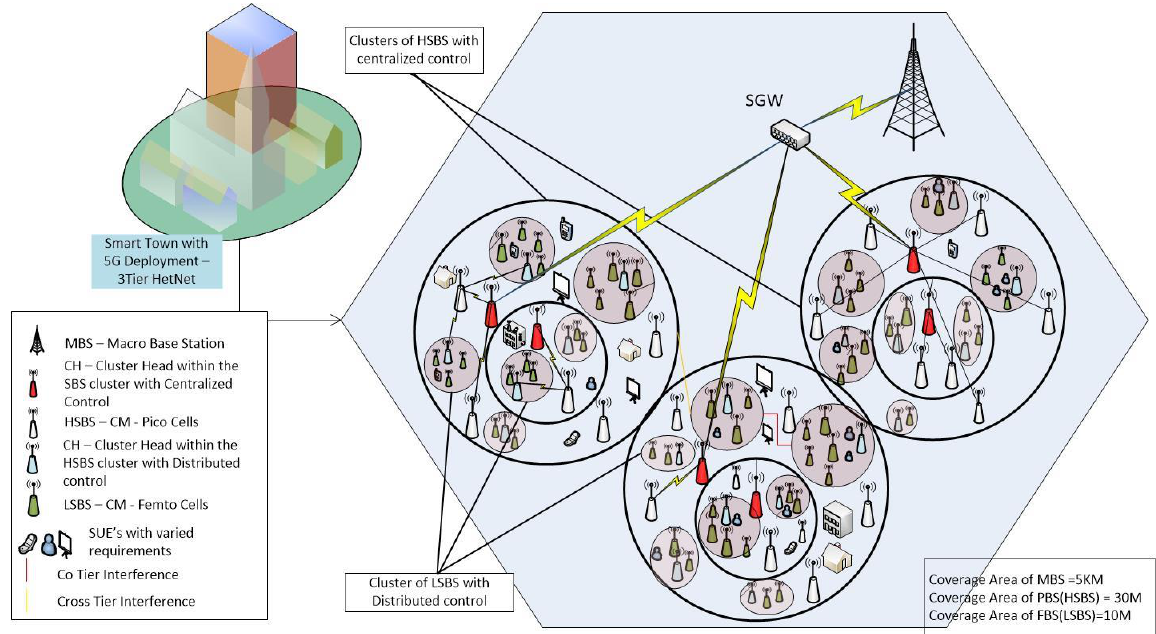
Figure 2. IMHC HetNet Model .